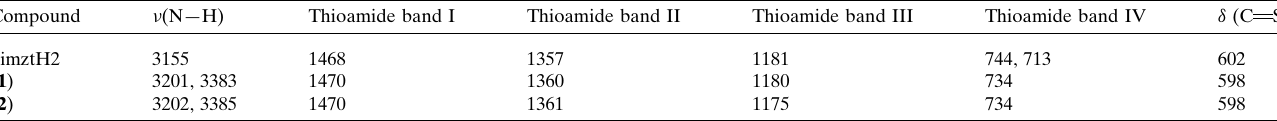
Table 3 IR peak assignments (cm (cid:3) 1 ) for the bimztH2 ligand and ( 1 ) and ( 2 ). Compound